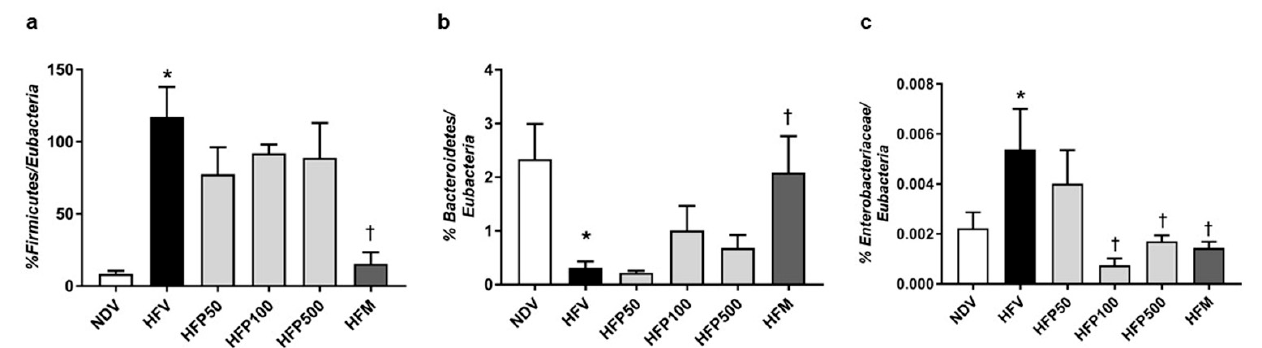
Figure 2. The effect of PSO administration on the composition of the gut microbiota in HFD-fed rats. ( a ) Percentage of Firmicutes/Eubacteria ; ( b ) Percentage of Bacteroidetes/Eubacteria ; ( c ) Percentage of Enterobacteriaceae/Eubacteria . Data are presented as mean ± SEM, * p < 0.05 versus the NDV group; † p < 0.05 versus the HFV group. HFD = High fat diet; NDV = Normal diet-fed rats treated with the vehicle; HFV = High fat diet-fed rats treated with vehicle.